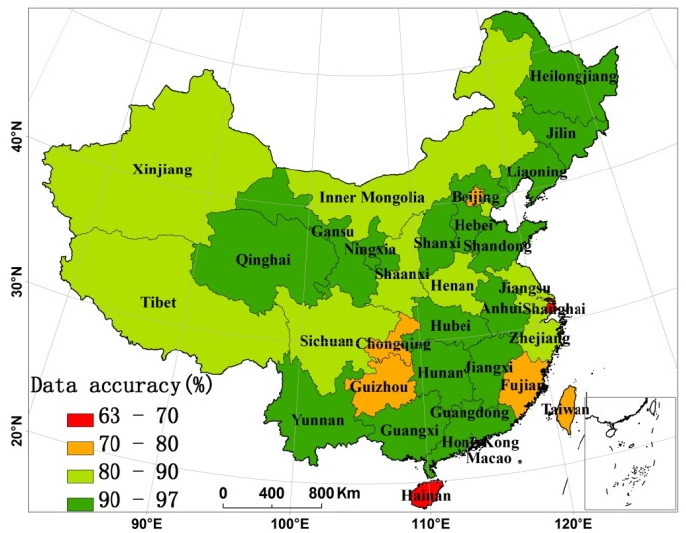
Figure 1. Interpretation accuracy of forest data in different provinces in 2000.